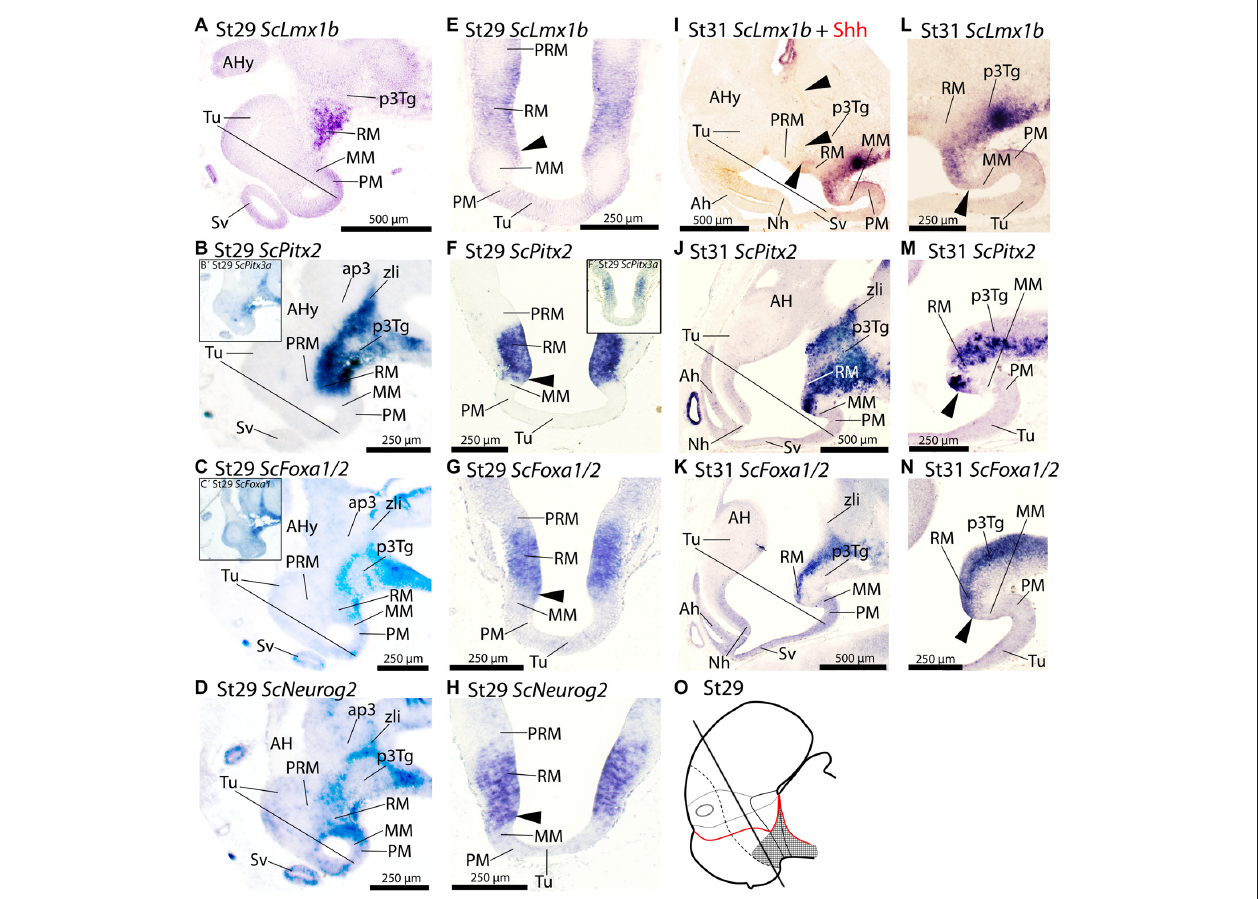
FIGURE 4 | Regionalization of the basal hypothalamus and neighbor territories in embryos of S. canicula at stages 29–31 based on the expression of ScLmx1b (A,E,I,L) , ScPitx2 (B,F,J,M) , ScPitx3a (B (cid:48) ,F (cid:48) ) , ScFoxa1/2 (C,C (cid:48) ,G,K,N) and ScNeurog2 (D,H) in sagittal (A–D,I–N) and transverse (E–H) sections. The level of transverse sections is indicated in the scheme (O) . For simplicity, the schemes do not represent medial (acroterminal) expression patterns. Some in situ sections were double labeled for IHC against Shh (I) . (A–D) Equivalent sagittal sections of embryos at stage 29 showing the similar pattern of expression of ScLmx1b, ScPitx2, ScFoxa1 / 2 and ScNeurog2 . Insets (B (cid:48) ) and (C (cid:48) ) show similar results when using ScPitx3a and ScFoxa1 probes . (E–H) Transverse equivalent sections showing that, in any case, the expression of ScLmx1b, ScPitx2a, ScFoxa1 / 2 and ScNeurog2 is restricted to the RM. Arrowheads points the sharp limit where the expression of these genes is abutting the negative MM. Inset (F (cid:48) ) show that ScPitx3a expression is similar to that of ScPitx2 shown in (F) . (I–N) Panoramic views (I–K) and details (L–N) of sagittal sections to show similar patterns of expression of ScLmx1b, ScPitx2a and ScFoxa1 / 2 in the RM. Arrowheads in (I) point immunoreactivity to Shh in the RM and zli. Arrowheads in (L–N) point the region where the expression of such genes abuts the negative MM. For abbreviations, see